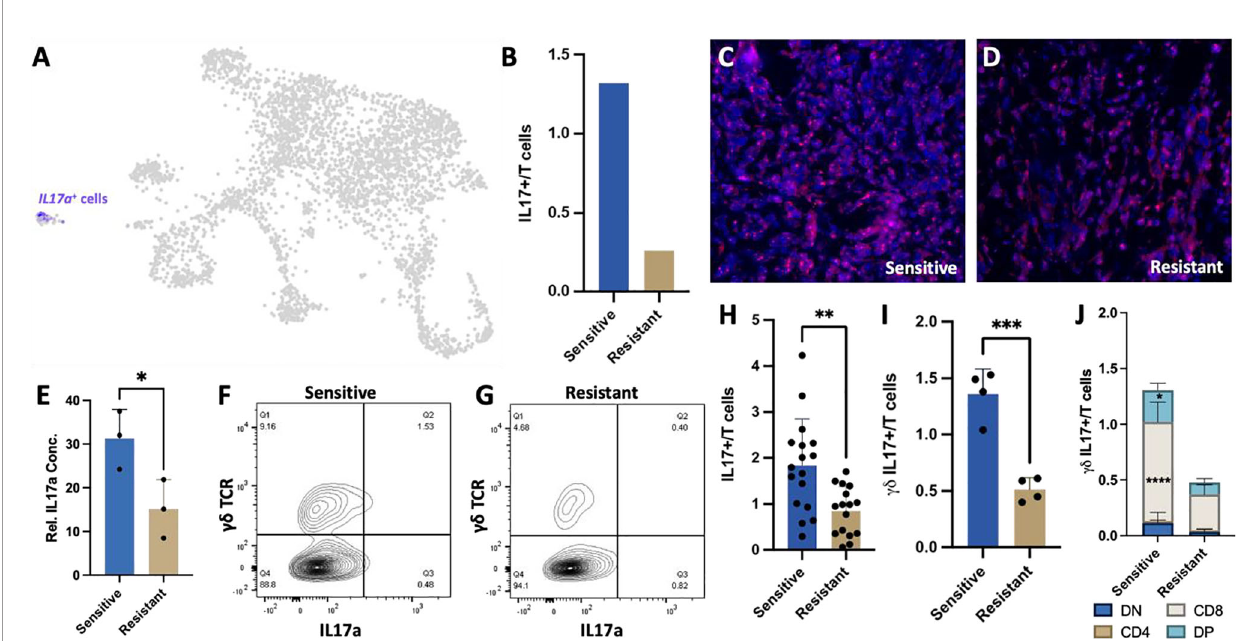
FIGURE 5 | Increased gd IL-17+ T cells in the DOX sensitive tumor microenvironment. (A) UMAP projection of 4T1 syngeneic tumor cells identifying that IL17a expression is restricted to gd T cells. (B) Ratio of IL17a+ cells in sensitive and resistant tumors extrapolated from scRNA-Seq data. (C, D) Representative immunohistochemistry images of IL17A expression in 4T1 tumor sections from sensitive and resistant tumors following DOX therapy. (E) Protein abundance quanti fi cation in tumors normalized to GAPDH expression (n=3). (F, G) Representative fl ow cytometry plots identifying gd IL-17+ T cells in T cell populations. (H) Quantitation of IL17A+ T cells from DOX sensitive and resistant tumors. (I) Quantitation of gd IL17A+ T cells from DOX sensitive and resistant tumors (n=4). (J) Distribution of gd IL17A+ T cells identifying expanded CD8 and double positive (CD4+CD8+) cells in sensitive tumors (n=4). * p ≤ 0.05, ** p ≤ 0.01, *** p ≤ 0.001, **** p ≤